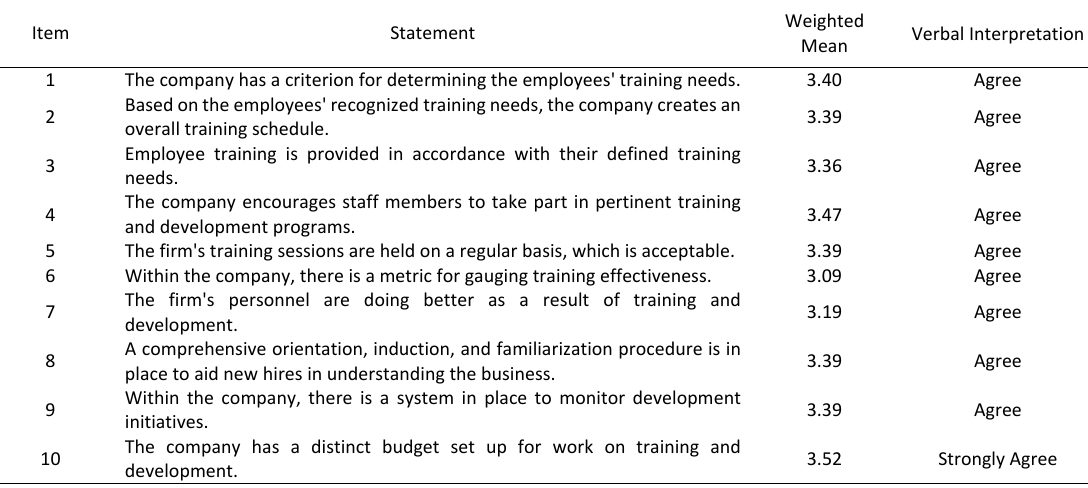
Table 7: Attitude of the respondents towards Training and Development practices